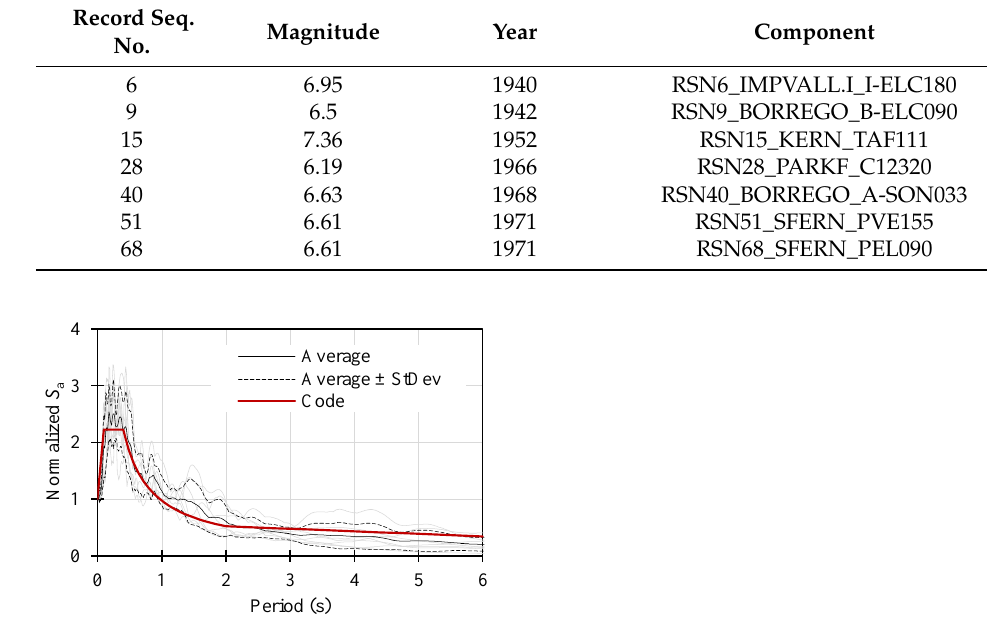
Figure 5. Normalized response spectra of selected